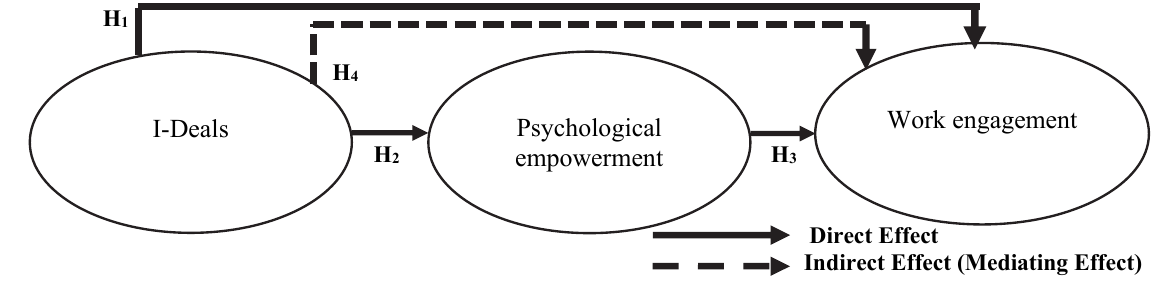
Fig. 1. The proposed